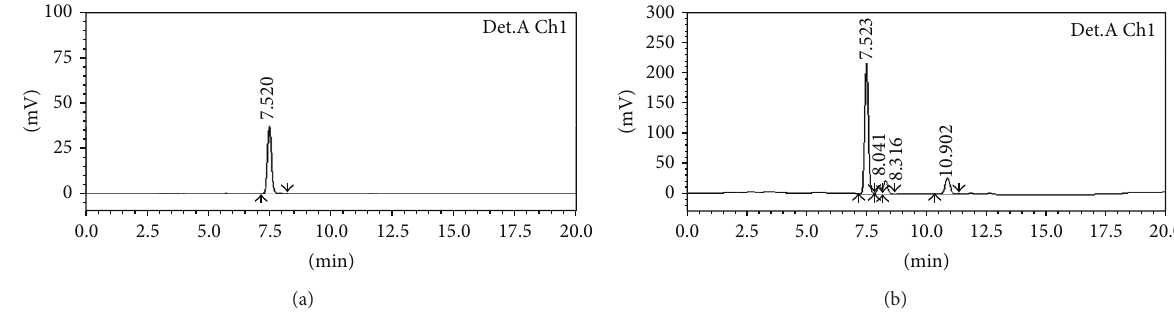
Figure 2: (a) Chromatograms of puerarin standard by HPLC. The data were reported as means ± standard deviation. (b) Chromatograms of puerarin sample by HPLC. The data were reported as means ± standard deviation.